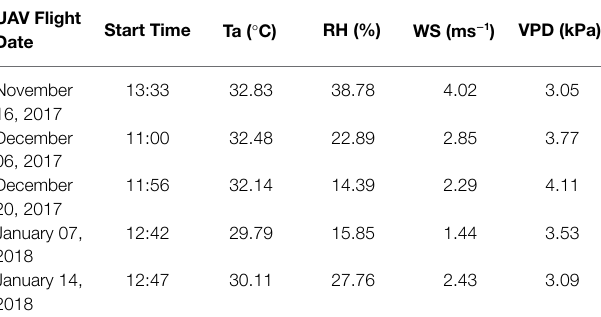
TABLE 1 | UAV data collection date, start time and coincident mean air temperature